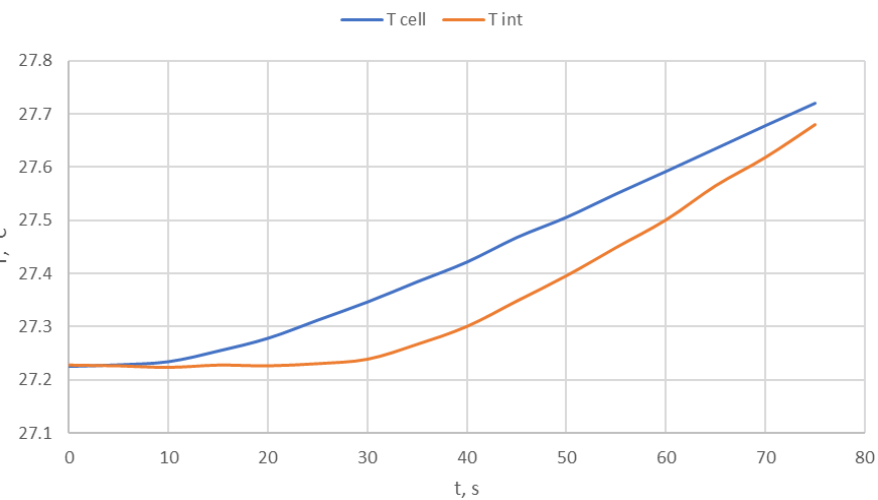
Figure 2. Cell and internal adiabatic shell temperatures (°C) vs. time (s) at P 0 ‧ 1 (t) cell heater power and common PID controller for internal shell heater.